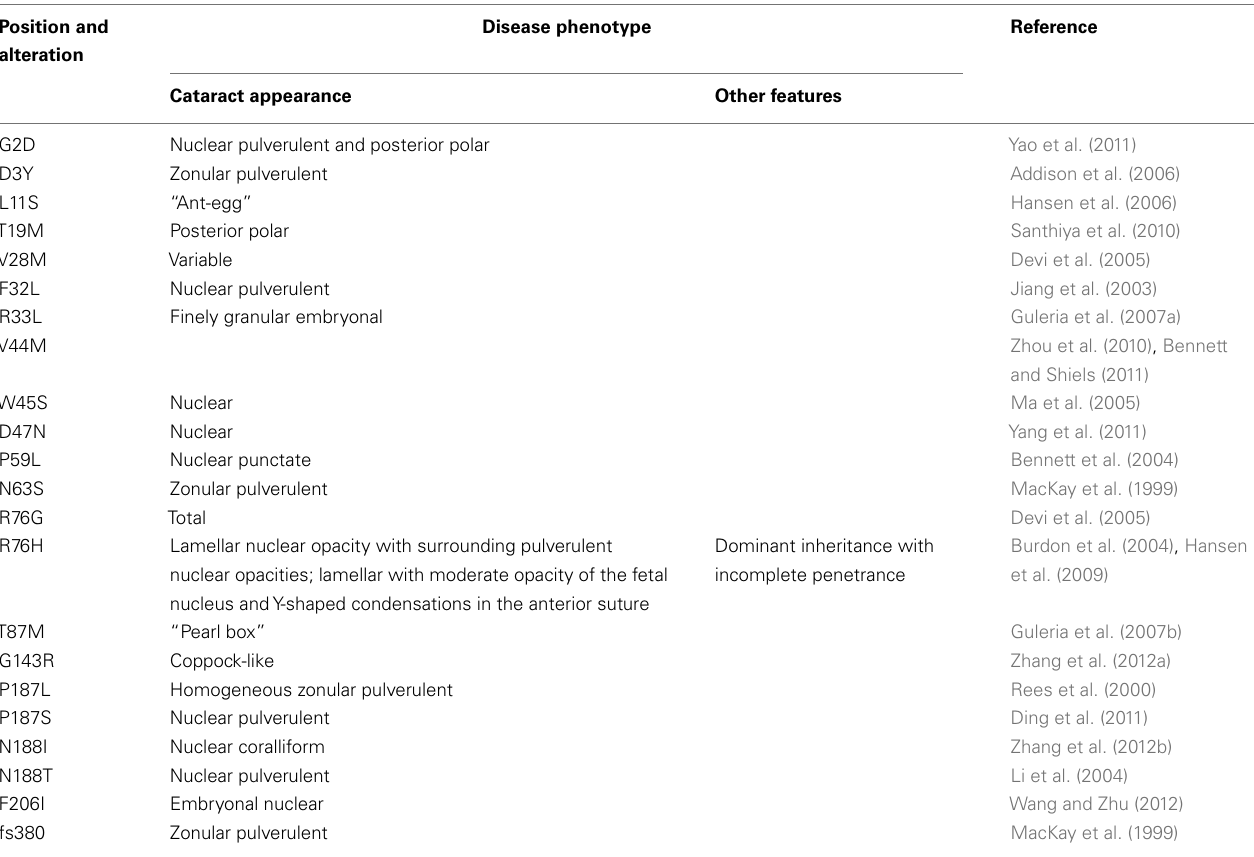
Table 1 | Human Cx46 mutants linked to cataract